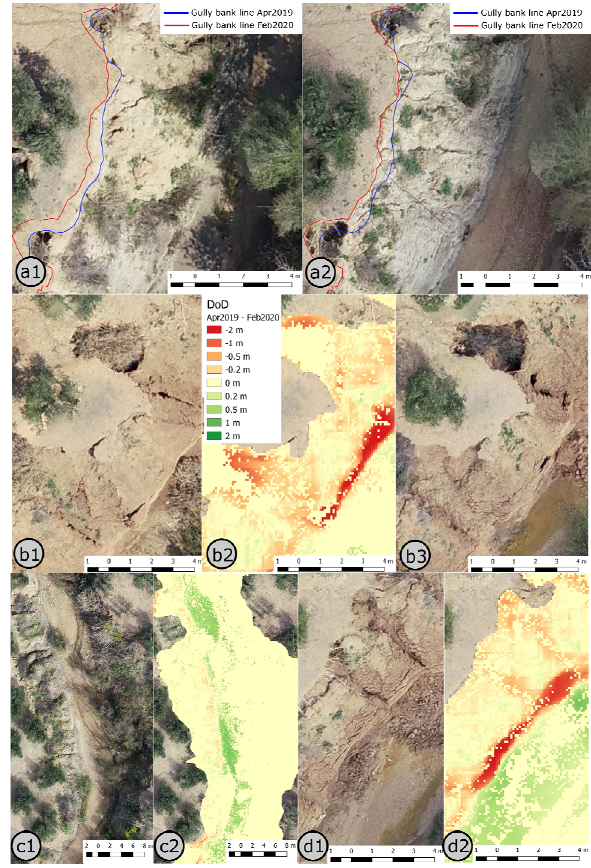
Figure 5. Details of erosion processes: a: Retraction of the gully bank lines; b: Slab falls in the gully walls; c: Deposition in the gully bottom; d: Excavation of gully walls. Orthophotographs correspond to April-2019 (abcd-1) and February 2020 (acd2- b3). DoDs correspond to whole period (Apr19-Feb20,